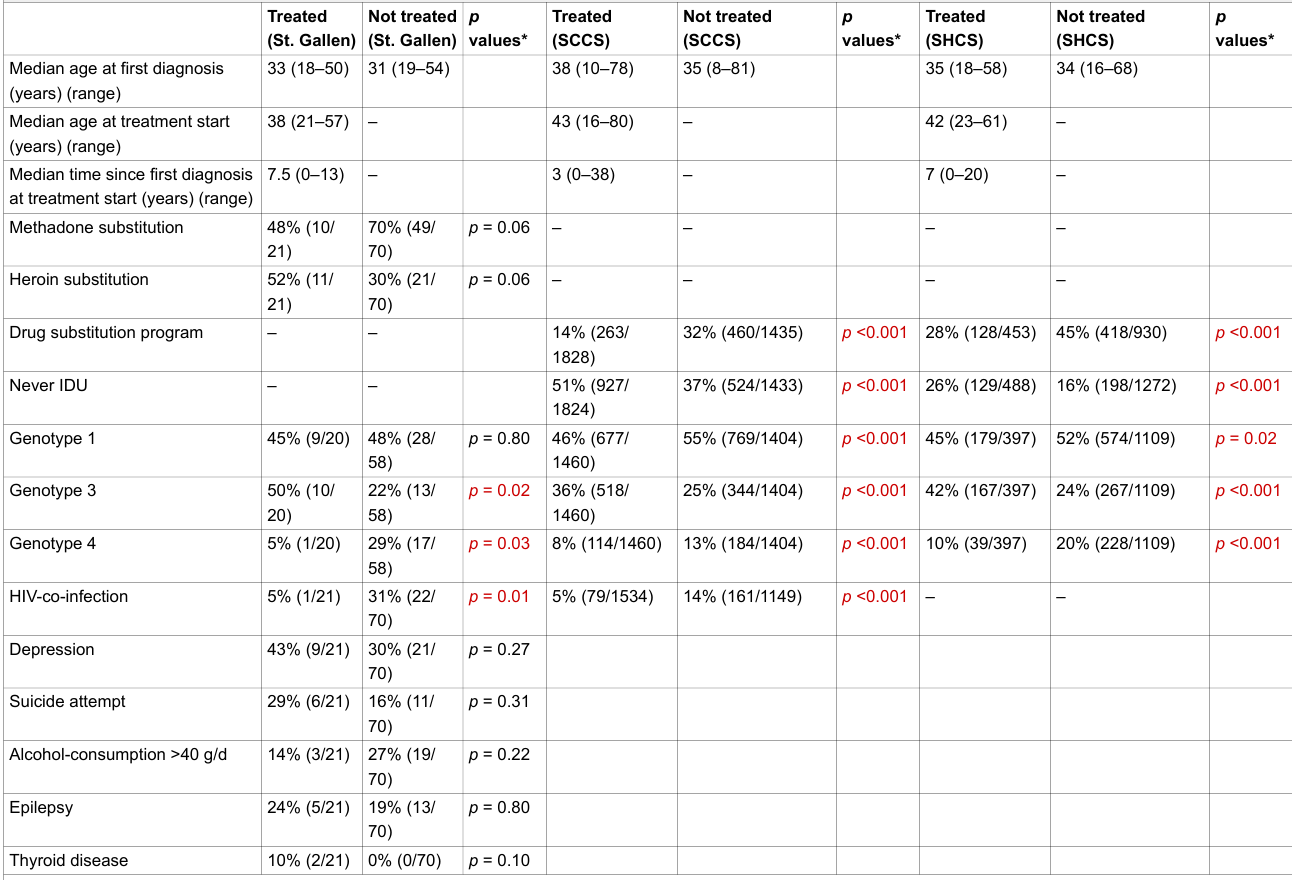
Treated Not treated p Treated (St. Gallen) (St. Gallen) values*